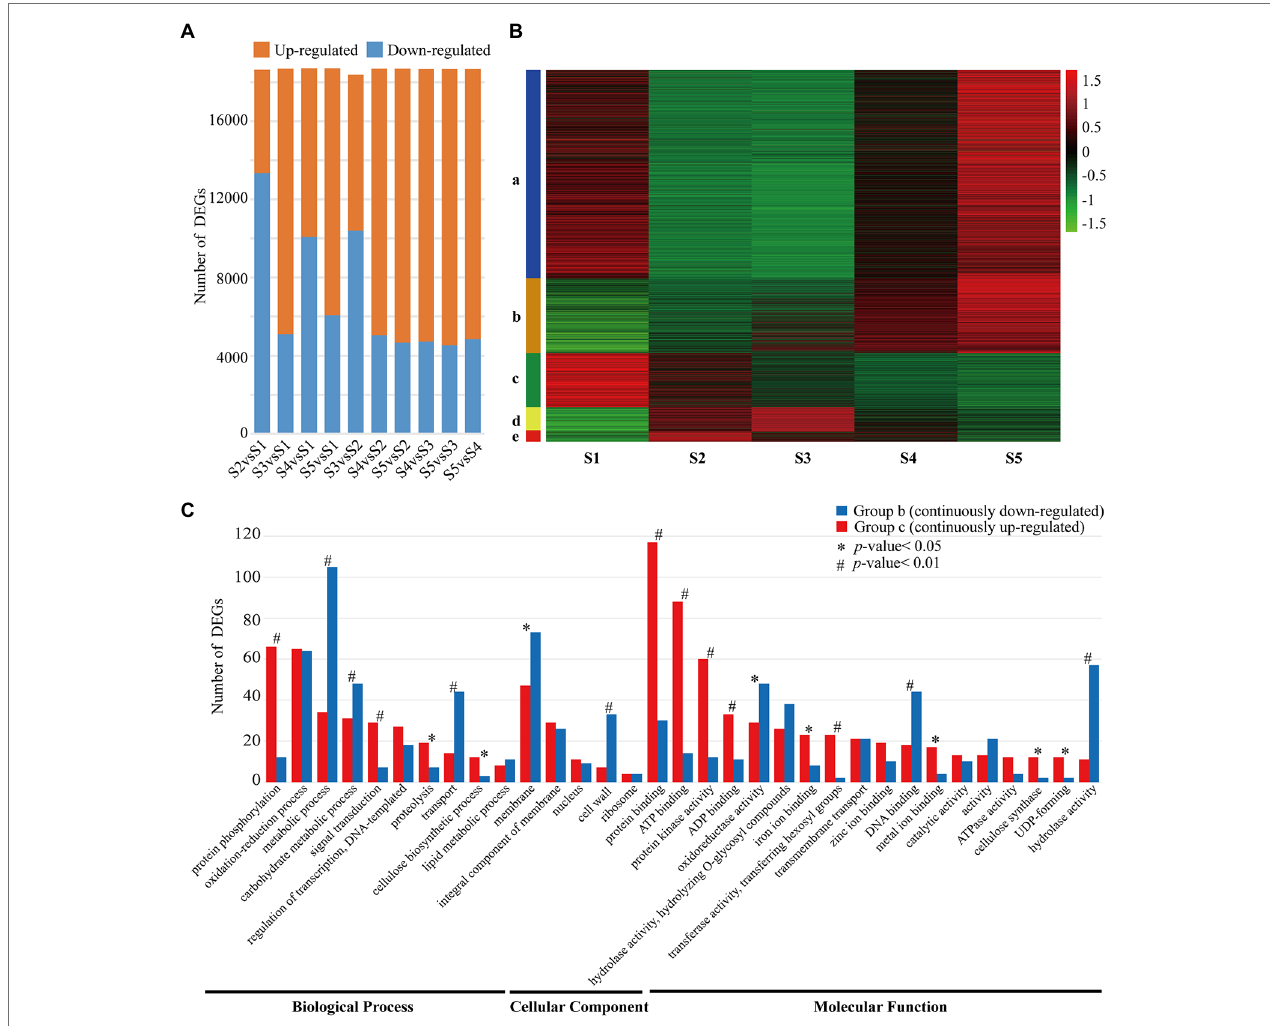
FIGURE 1 | Profiling of DEGs between Cunninghamia lanceolata stem segments. (A) Number of DEGs between different samples. Upregulated and downregulated DEGs were marked with orange and blue, respectively. (B) Expression profiles of DEGs in five different samples. (C) GO classification of upregulated and downregulated DEGs. * and # indicate significant differences at 5% and 1%,